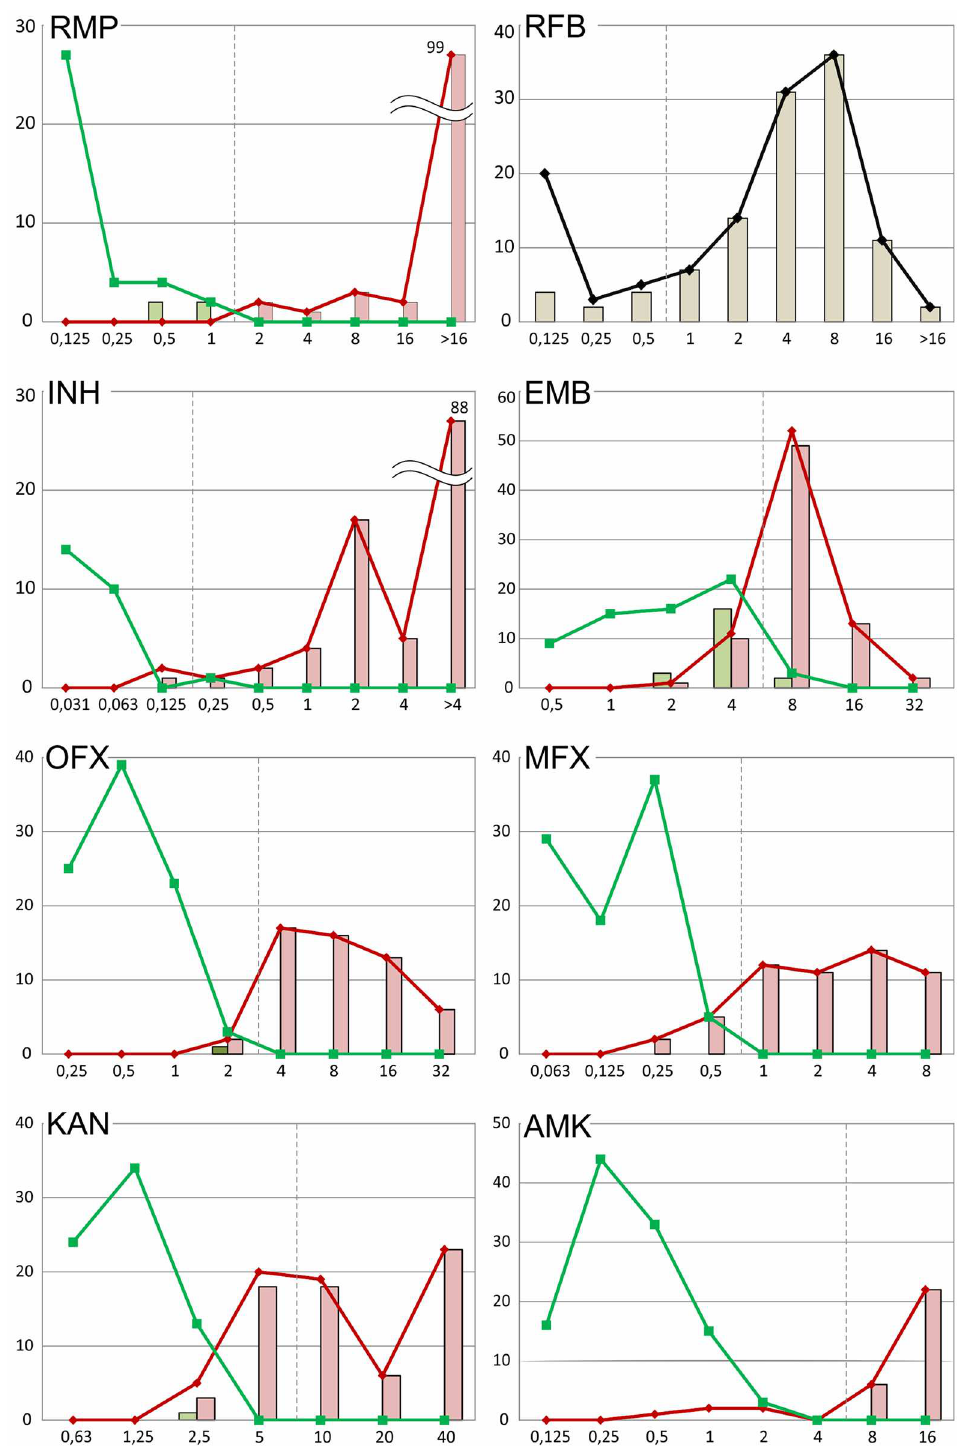
Fig 1. MIC distributions of the clinical isolates characterized using the MGIT and TB-TEST assays. Resistant and susceptibleisolates based on the MGIT results are indicatedby the red and green lines, respectively.The light-redand light-greenbars represent the numbers of resistant and susceptible isolates with mutations detected by the TB-TEST. The MGIT was not performed for rifabutin (RFB); therefore, only the distributionsof all isolates and the isolates with mutationsare